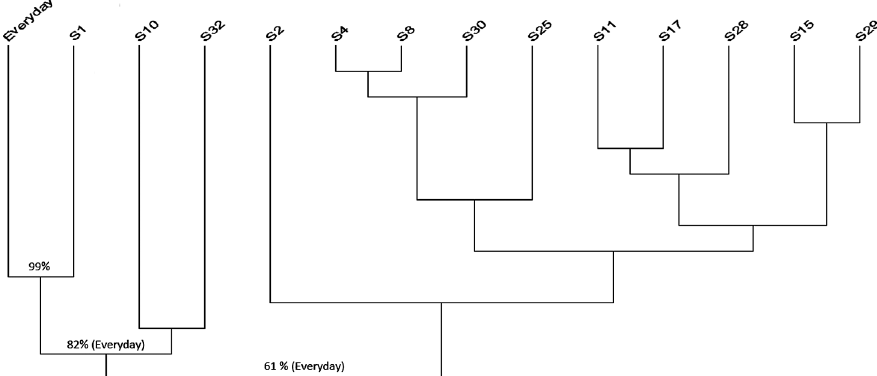
1. Similarity tree of real students ( s i ) in relation to the practical or everyday ideal student profile. Numbers represent the CHIC generated similarity levels between student clusters and the ideal profile.